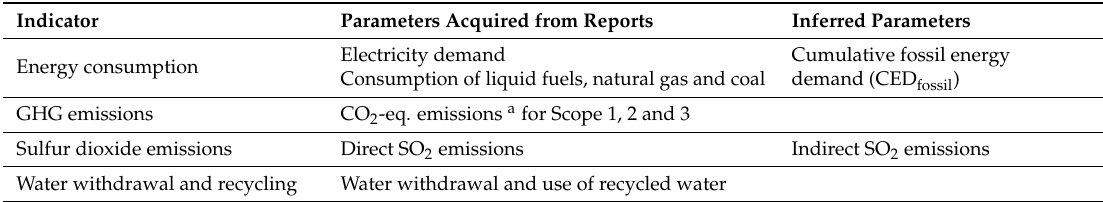
Table 1. Indicators and related